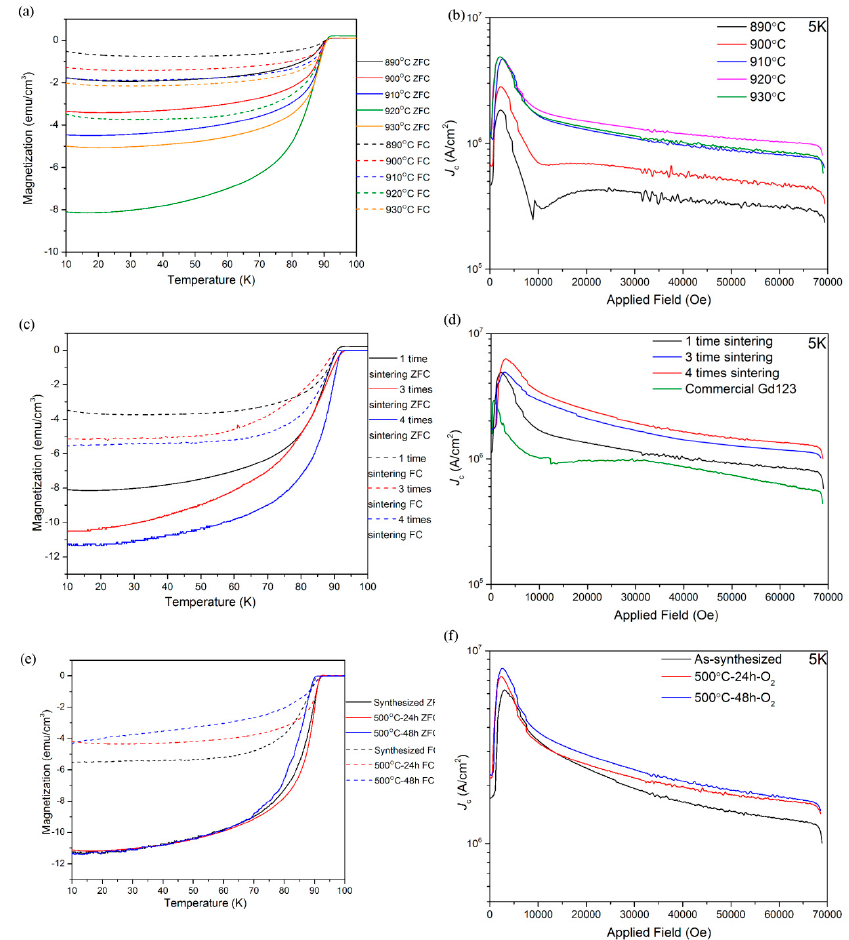
Figure 3. ( a ) ZFC and FC curves of the Er123 sintered by different temperature for 24 h; ( b ) J c vs B curve at 5 K of the Er123 sintered by different temperature for 24 h; ( c ) ZFC and FC curves of the Er123 sintered at 920 ◦ C for 24 h by multiple times; ( d ) J c vs B curve at 5 K of the Er123 sintered at 920 ◦ C for 24 h by multiple times; ( e ) ZFC and FC curves of the Er123 with oxygen annealing at 500 ◦ C for 24~48 h; ( f ) J c vs B curve at 5 K of the Er123 with oxygen annealing at 500 ◦ C for 24~48